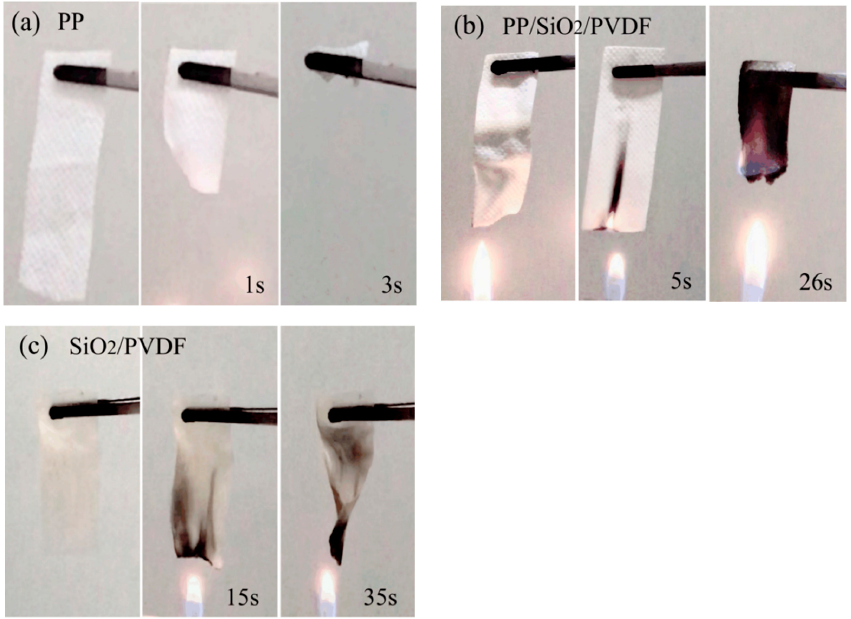
Figure 6. Combustion behavior of the materials: ( a ) PP; ( b ) PP / SiO 2 / PVDF and ( c ) SiO 2 /